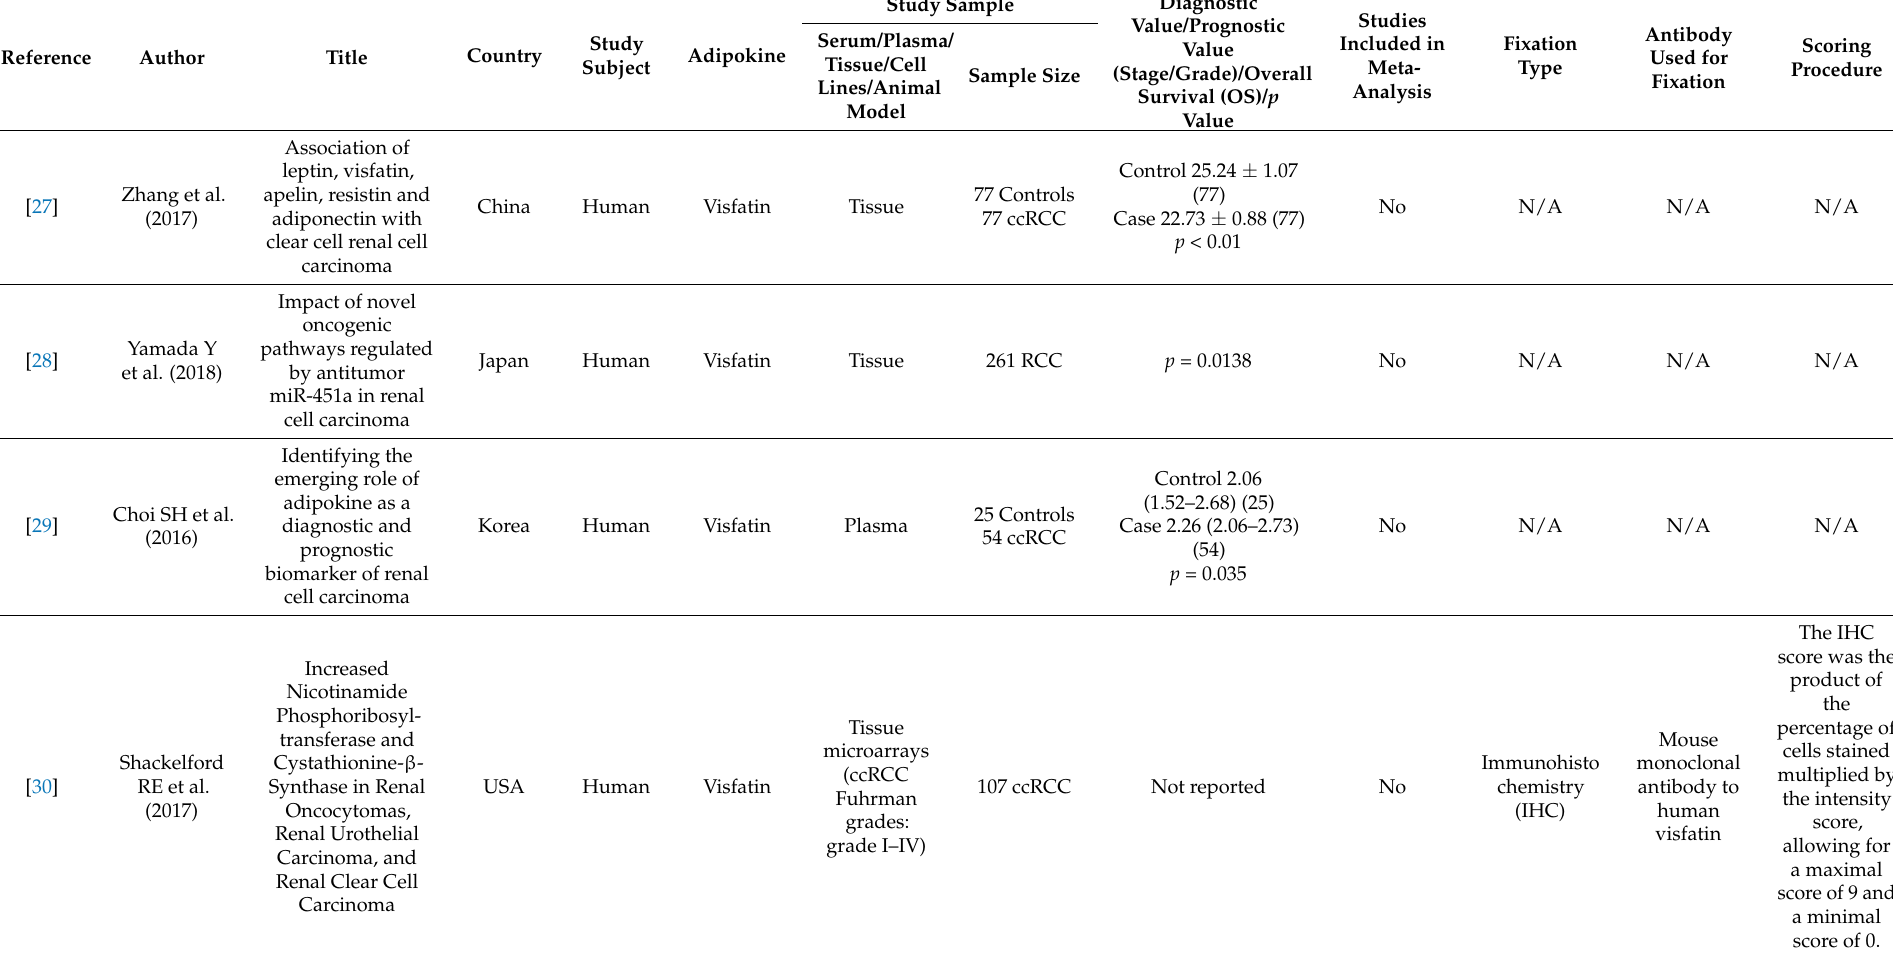
Table 1. Characteristics of included studies in the systemic review and